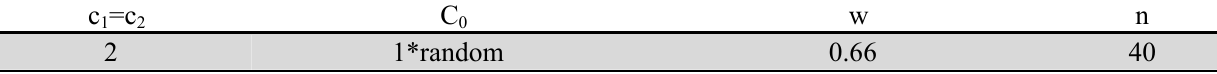
Particle swarm optimization algorithm